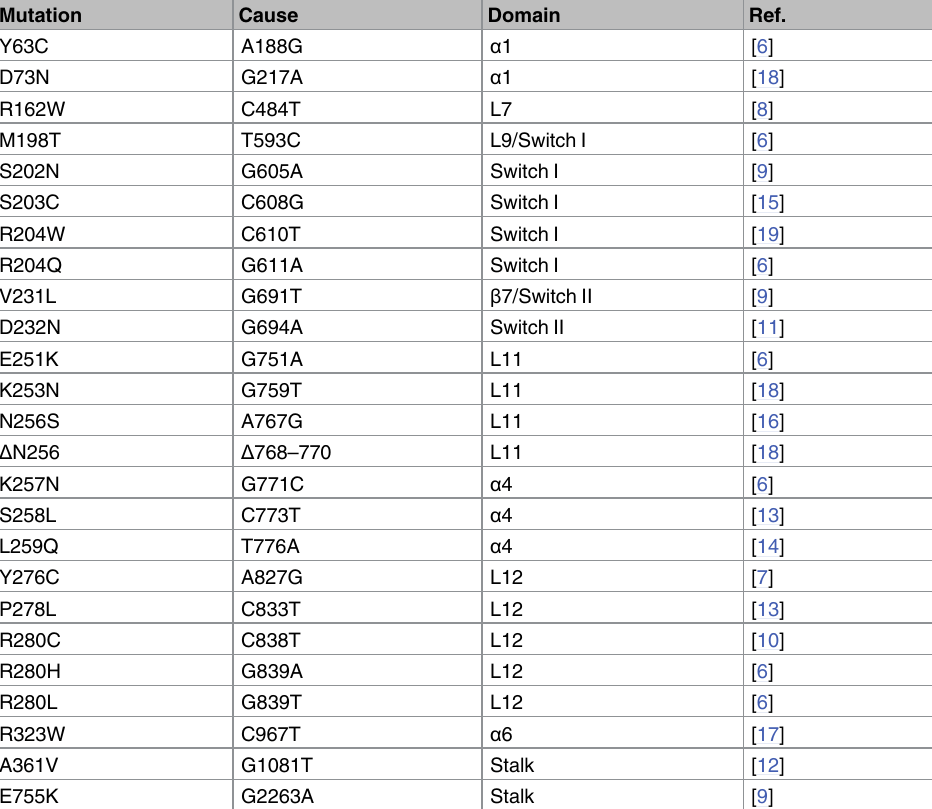
Table 1. Kif5A mutations that cause